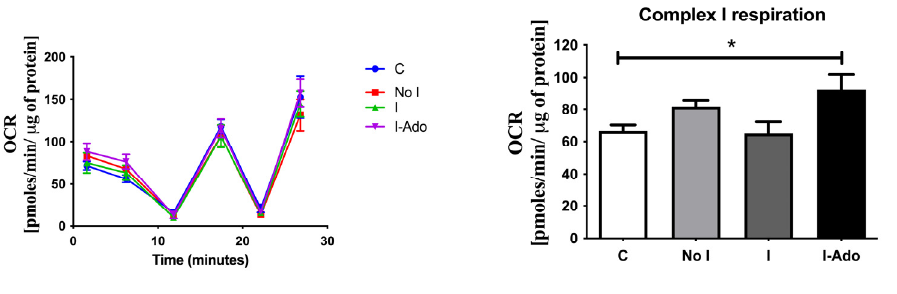
( b ) Figure 5. The 31 P NMR spectra based calculation of ( a ) free AMP concentration and ( b ) pH before, during, and after 1 min ischemia in hearts subjected to 1 min ischemia at 40 min of perfusion, 10 min ischemia at 50 min of perfusion, and 1 min ischemia at 85 min of perfusion without (Group I) or with (Group I-Ado) supply of adenosine at 30 µM concentration during the fi rst 15 min of reper-